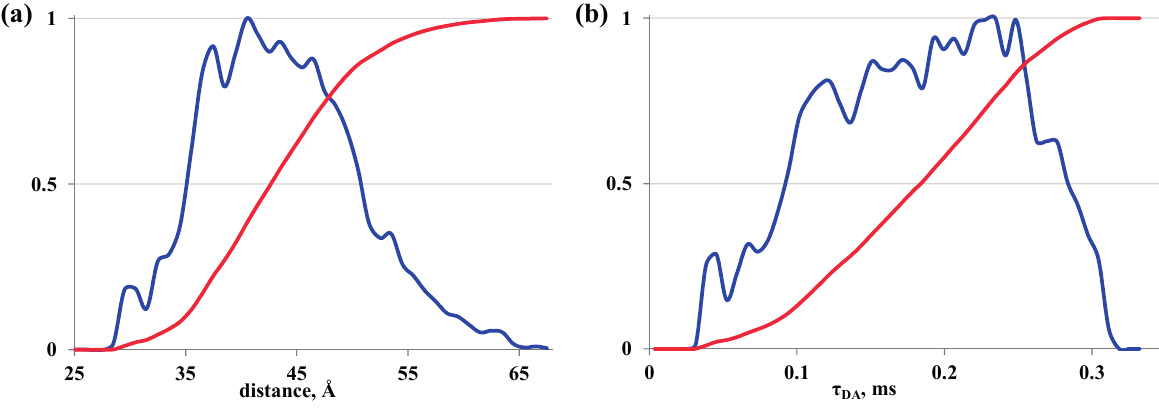
Figure 2. ( a ) Distance distribution between donor and acceptor (blue curve) and corresponding cumulative probability (red curve); ( b ) lifetime distribution τ DA (blue curve) and corresponding cumulative probability (red